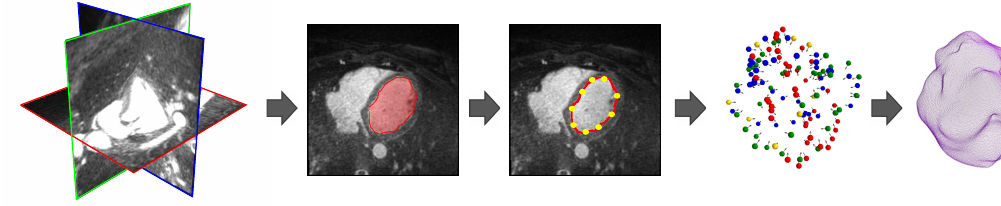
Figure 1. Segmentation pipeline. The first image from the left shows the 3D volume as input. In the next step, single slices are segmented using the Smart Brush functionality. Third, the control points of the contours are extracted. Fourth, the 2D and 3D normal vectors are computed for the Hermite radial basis function interpolation. In the final image, the interpolated surface is visualized ([2] Reproduced with